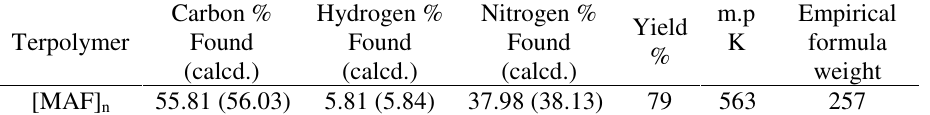
Table 1. Analytical data of terpolymer